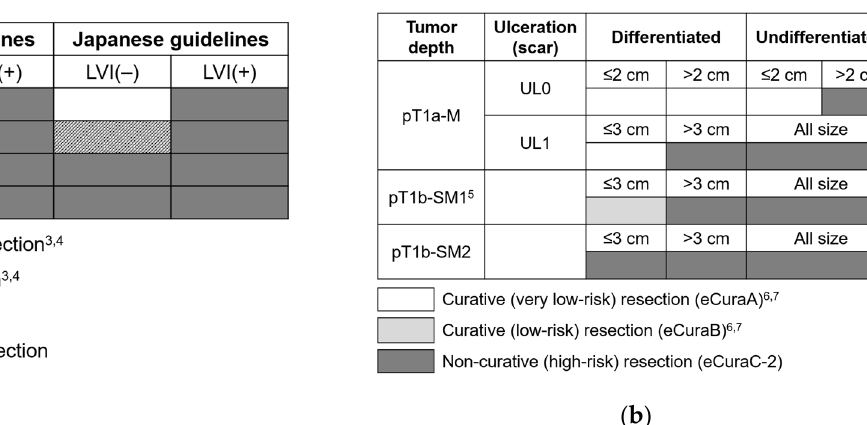
Figure 1. ( a ) Curability criteria after ER for SESCC; ( b ) EGC. 1 Poorly differentiated tumor is regarded as non-curative ER. 2 In the European guidelines, pT1a-MM/pT1b-SM1 with negative LVI is considered curative, but additional radiotherapy or CRT may be considered in a multidisciplinary discussion, particularly if the tumor diameter is > 20 mm. 3 Confined by negative horizontal and vertical margins with negative LVI. 4 Piecemeal resection or resection en bloc with a positive horizontal margin is regarded as non-curative ER. 5 A lesion with a submucosal undifferentiated component is regarded as non-curative ER (eCuraC-2) in the Japanese guidelines. 6 Confined by negative horizontal and vertical margins with negative LVI. 7 Piecemeal resection or resection en bloc with a positive horizontal margin is regarded as non-curative ER (eCuraC-1 in the Japanese guidelines). CRT, chemoradiotherapy; EGC, early gastric cancer; ER, endoscopic resection; LVI, lymphovascular invasion; pT1a-EP/LPM, tumor invasion limited to the epithelium or lamina propria mucosa; pT1a-M, intramucosal adenocarcinoma; pT1a-MM, tumor invasion confined to the muscularis mucosa; pT1b- SM1 (EGC), submucosal adenocarcinoma confined to <500 µ m of the submucosa; pT1b-SM1 (SESCC), tumor invasion confined to the submucosa ≤ 200 µ m; pT1b-SM2 (EGC), submucosal adenocarcinoma invading ≥ 500 µ m of the submucosa; pT1b-SM2 (SESCC), tumor invasion into the submucosa >200 µ m; SESCC, superficial esophageal squamous cell carcinoma.